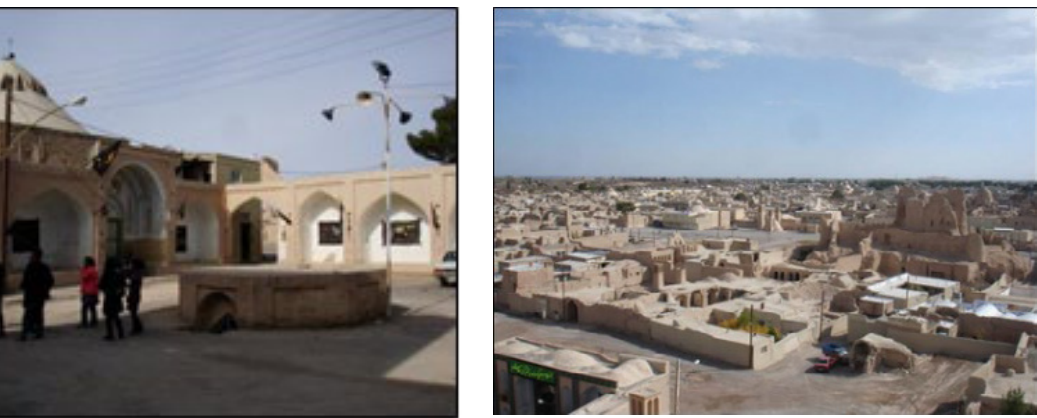
Fig. 3: Physical and functional centrality Fig. 4: Physical texture cohesion Fig 3: Physical and functional centrality Fig 4: Physical texture cohesion Fig 3: Physical and functional centrality Fig 4: Physical texture cohesion